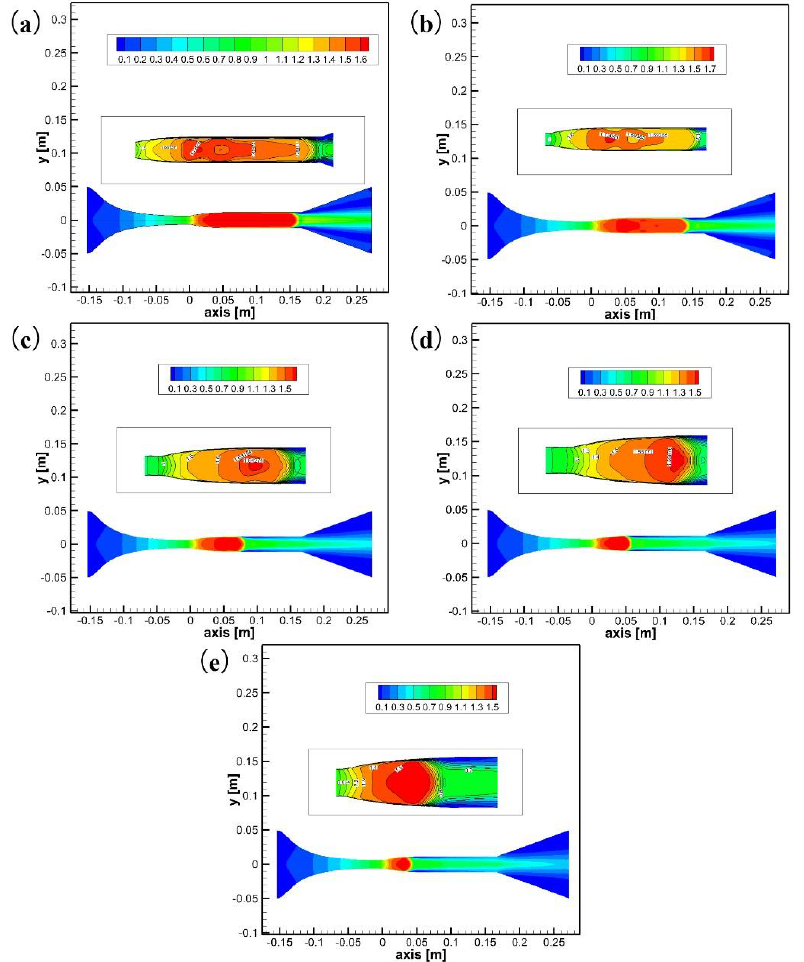
Figure 8. Mach number distribution along the axial cross-section of the supersonic separator at ex- port back pressure values ( a ) 1.6 MPa; ( b ) 1.8 MPa; ( c ) 2.2 MPa; ( d ) 2.3 MPa, and ( e ) 2.4 MPa.